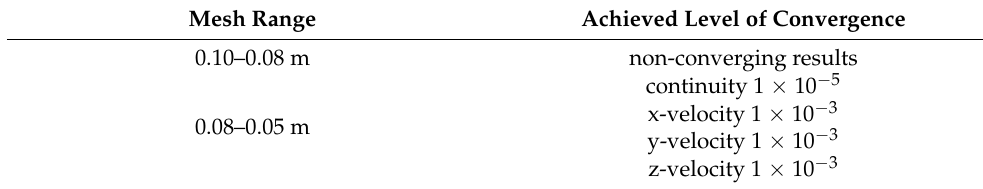
Table 1. Results for the mesh independent test.